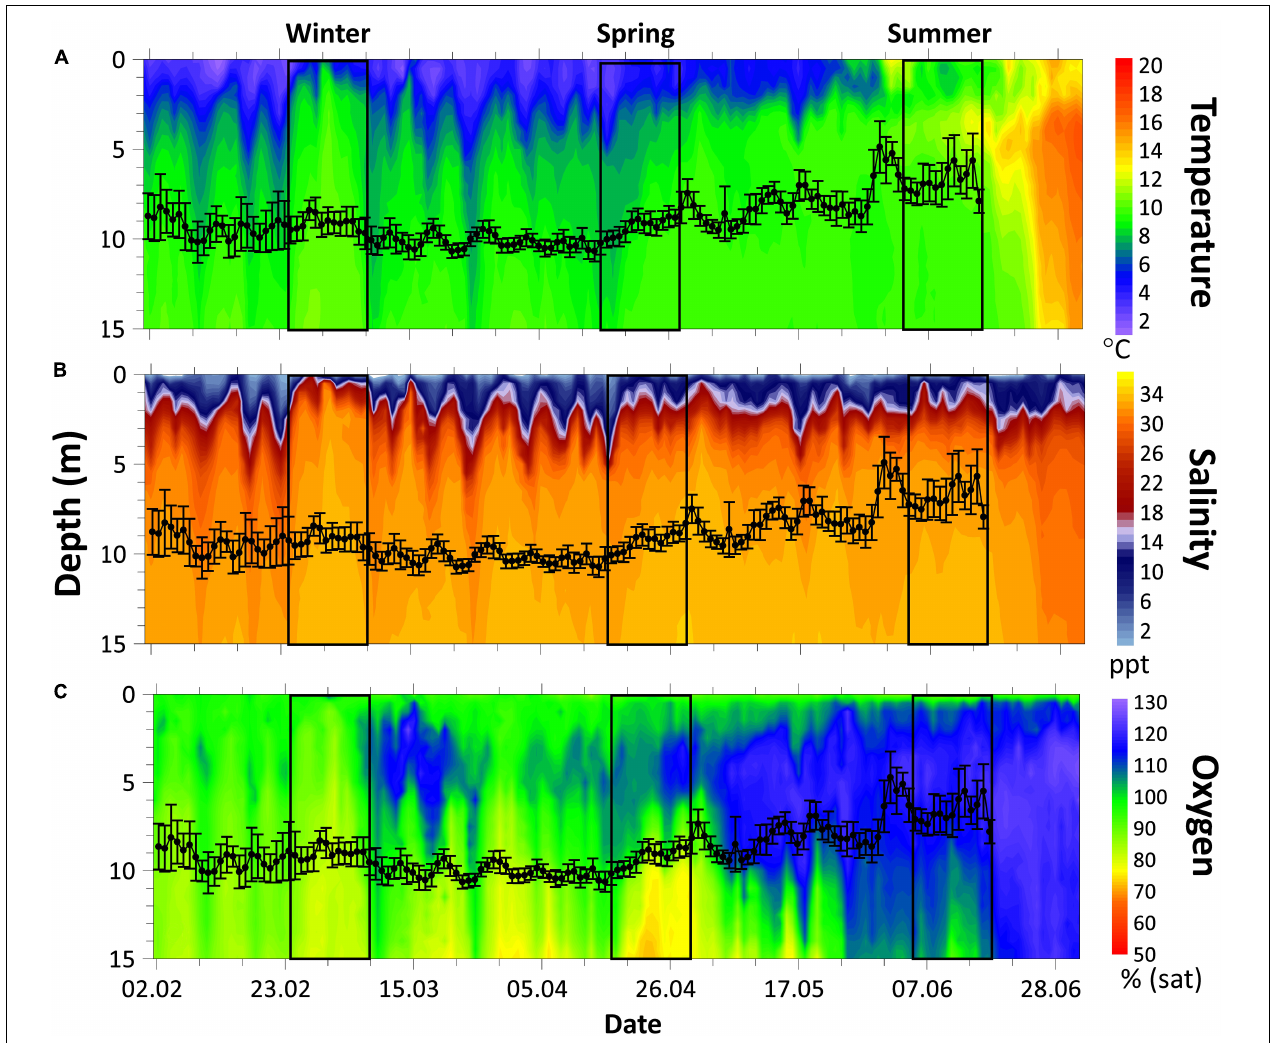
FIGURE 1 | Environmental contour plot from the 2nd February to the 2nd of July. About 0–15 m depth of water temperature (A) , salinity (B) , and oxygen saturation (C) . Black line represents 24 h mean swimming depth ( ± 1 SD) of all fish in the cage estimated from the cage echo sounder data.